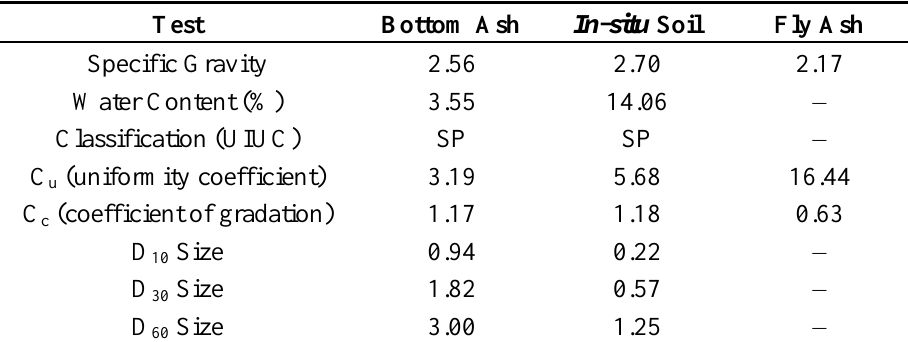
Table 1. Selected properties of the soils and fly ash.